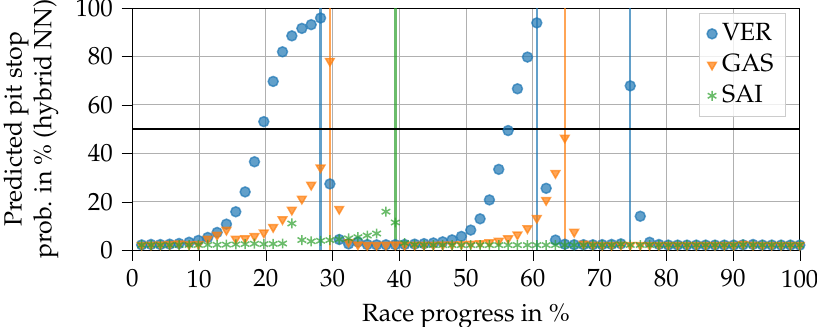
Figure 8. Progressions of pit stop probabilities for three drivers predicted by a hybrid NN using real input data from the 2019 Brazilian Grand Prix. The vertical lines indicate that a real pit stop was made by the respective driver. The horizontal line at 50% probability separates the no pit stop from the pit stop region. The race was excluded from the training data. Driver abbreviations: VER—Verstappen, GAS—Gasly,